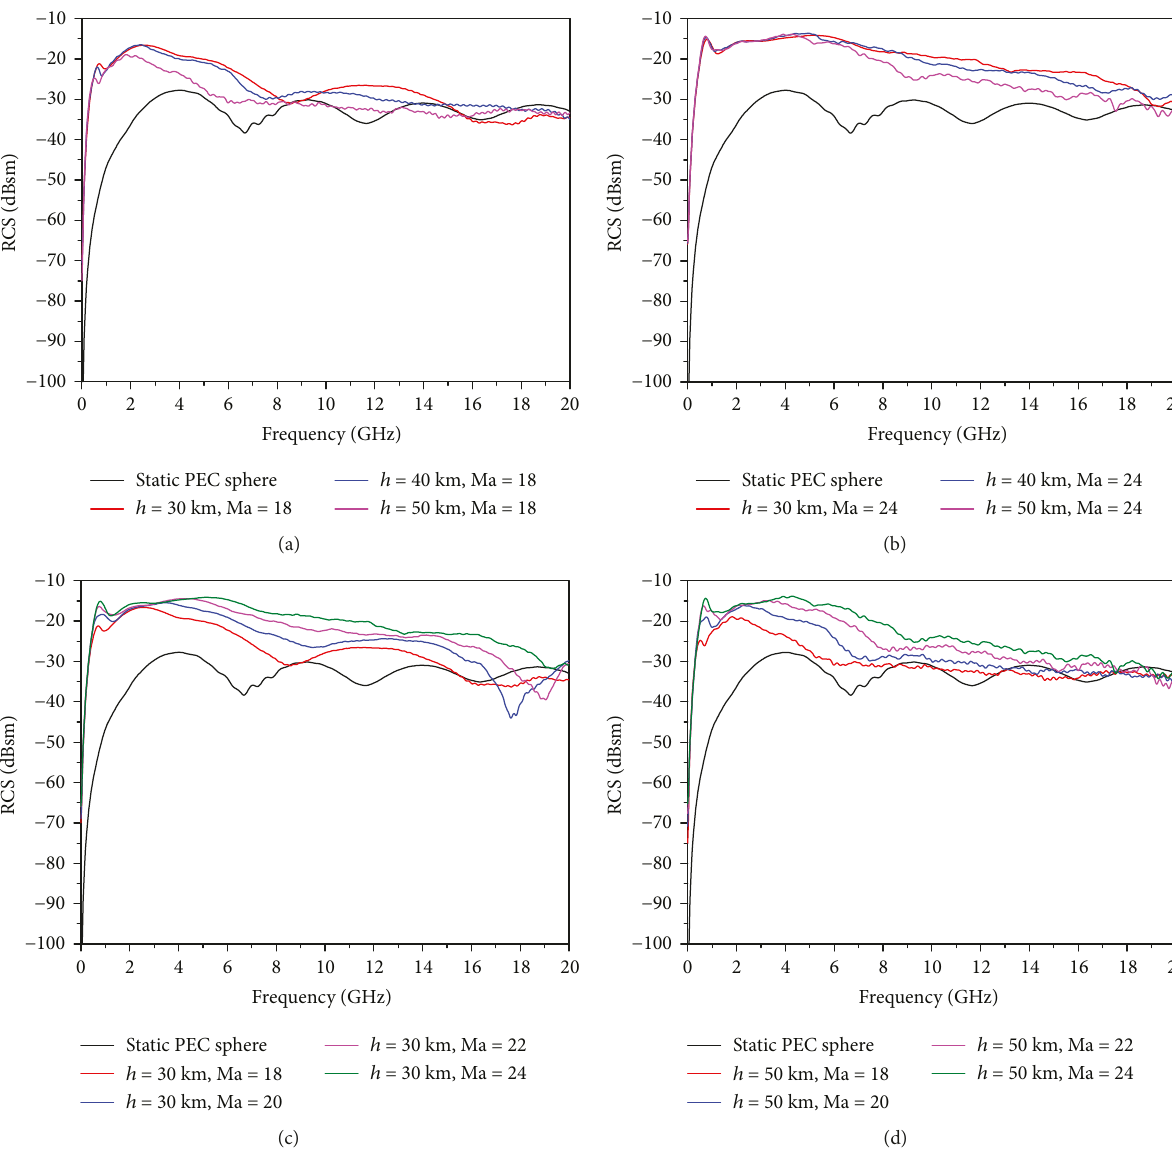
Figure 8: Distributions of backward RCS against frequency for a hypersonic sphere enveloped by a plasma fl ow illuminated by a polarized plane wave with incident angles ( θ = 90 0 ∘ , φ = 90 0 ∘ ). HH RCS components are plotted for di ff erent fl ight conditions. (a) Di ff erent heights, Ma = 18 ; (b) di ff erent heights, Ma = 24 ; (c) h = 30 km, di ff erent velocities; (d) h = 50 km, di ff erent